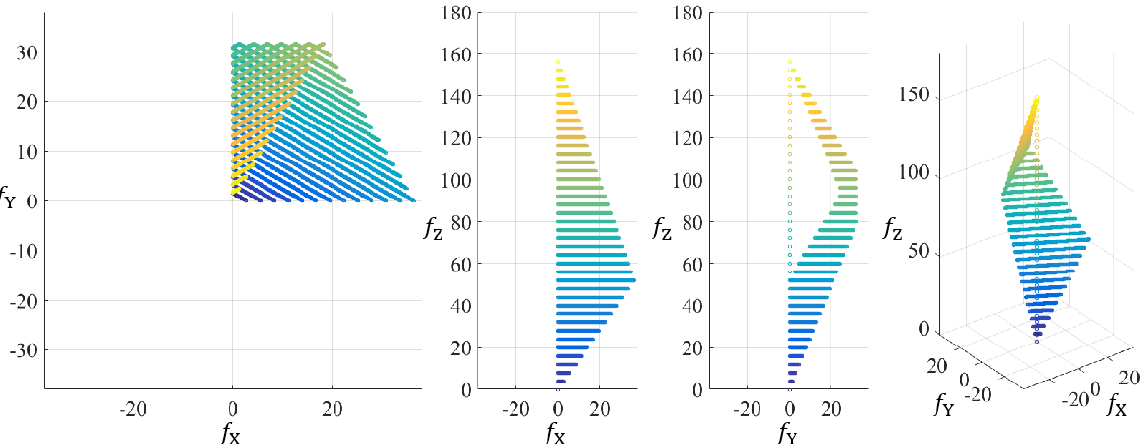
Figure 7. 3D cloud of points for propulsion forces margins.